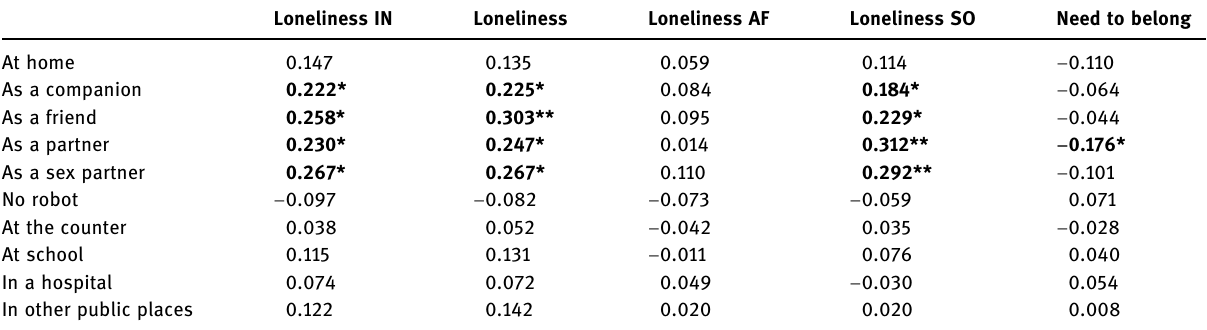
Table 5: Spearman ’ s rank correlation coe ffi cients ( r s ) between Loneliness , Need to belong , and Wish to see a robot at home/in public places Loneliness IN